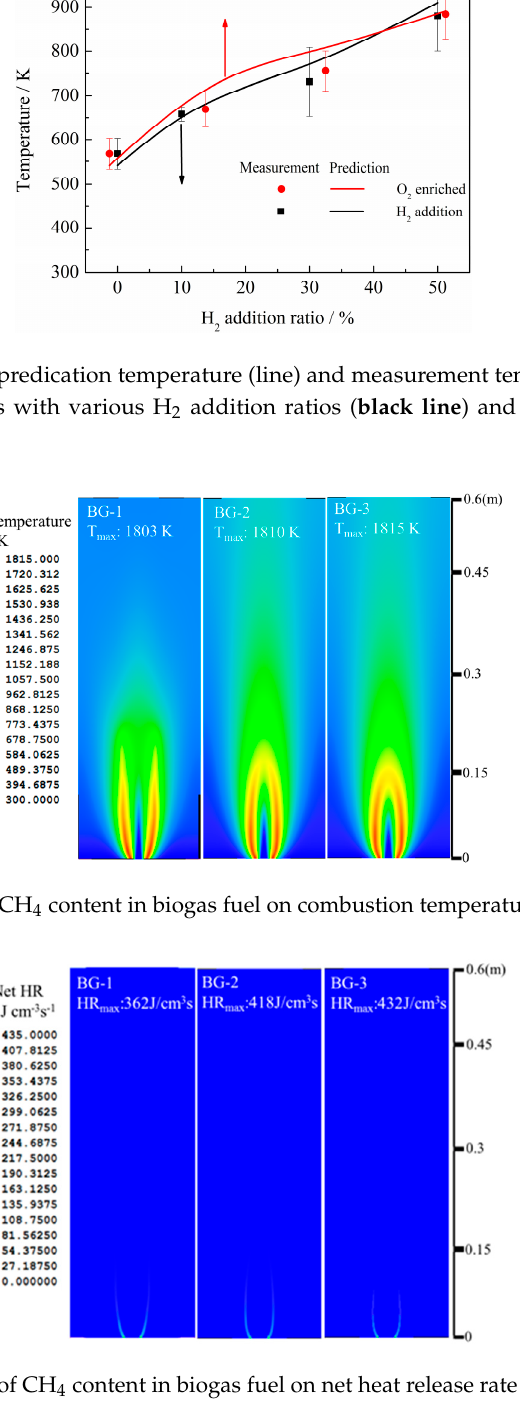
Figure 4. Effect of CH 4 content in biogas fuel on net heat release rate distribution.